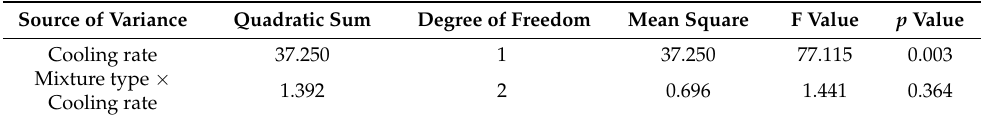
Table 10. Covariance analysis of the effect of the cooling rate (SBS-modified